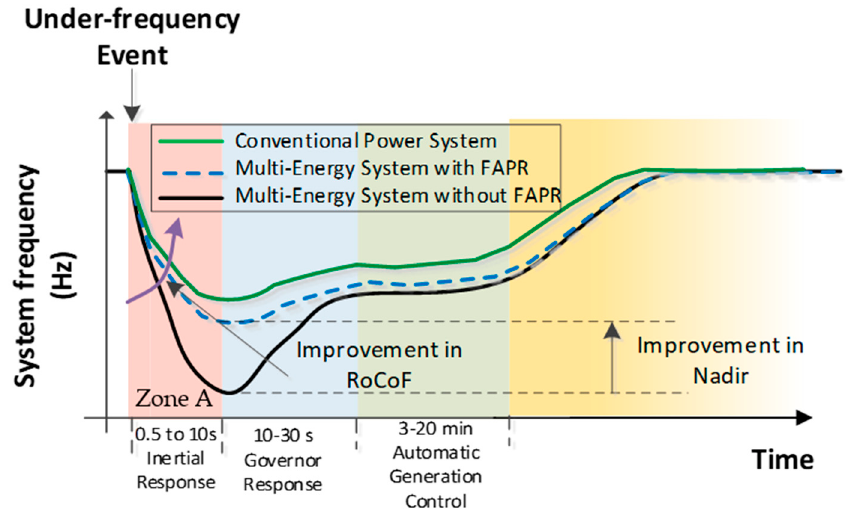
Figure 1. Expected influence of fast active power regulation (FAPR) in under-frequency events.